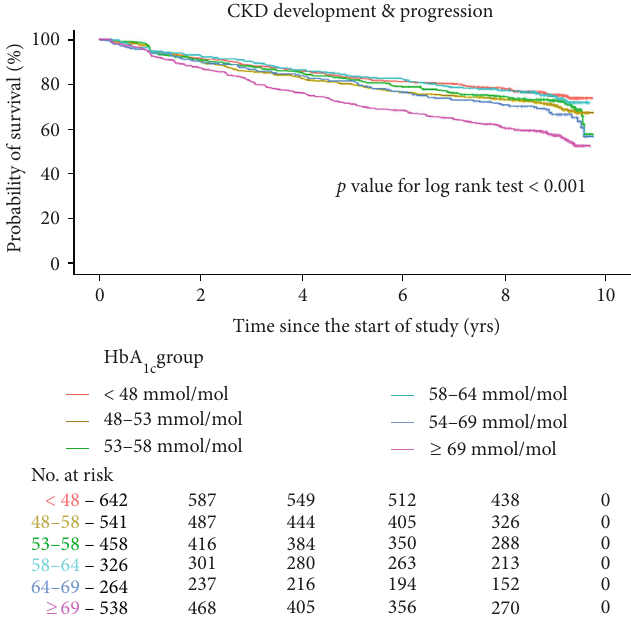
Figure 2: Kaplan-Meier curves for the development or progression of chronic kidney disease according to baseline glycated hemoglobin. Abbreviations: HbA : glycated hemoglobin; CKD: chronic kidney disease; No.: number. Kaplan-Meier curves strati fi ed by baseline HbA 1c into six groups. Renal outcome was de fi ned as a composite event of the fi rst CKD development in the CKD-naïve group ( n = 2357 ) and CKD progression in the preexisting CKD group ( n = 412 ).